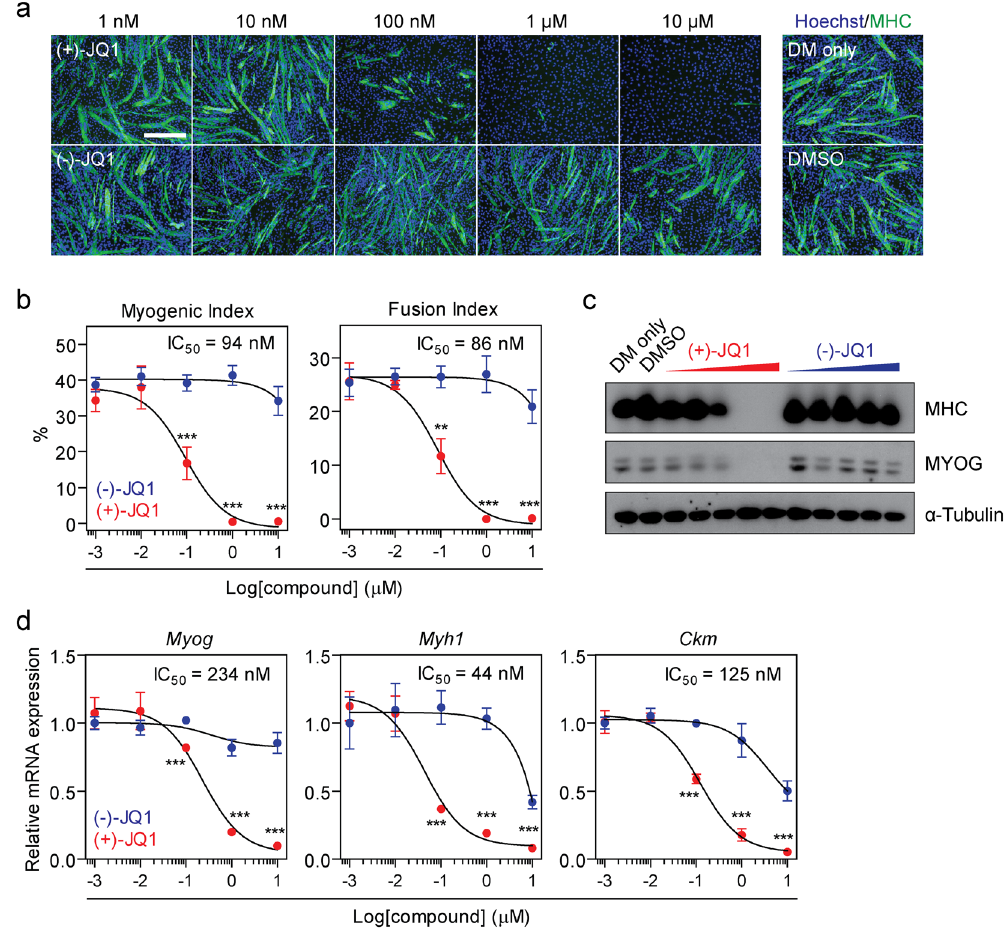
Figure 2. Inhibition of myogenic differentiation by ( + )-JQ1 is dose-dependent. C2C12 cultures were treated with ( + )-JQ1, or ( − )-JQ1 negative control enantiomer, over a range of concentrations (1 nM to 10 µ M) and myogenic differentiation assessed by ( a ) MHC IF staining, and ( b ) quantified using Myogenic and Fusion Indices. ( c ) MHC and MYOG protein levels were determined by Western blot. ( d ) Myh1 , Myog and Ckm mRNA levels were determined by RT-qPCR. All images were taken at 10 × magnification, scale bars indicate 50 µ m. Blots were cropped for conciseness and clarity. All values are mean + / − SD, n = 4 representative fields of view for microscopy, n = 3 for RT-qPCR, ** P < 0.01, *** P < 0.001 (unpaired t -test comparing ( + )-JQ1 and ( − )-JQ1 at each time